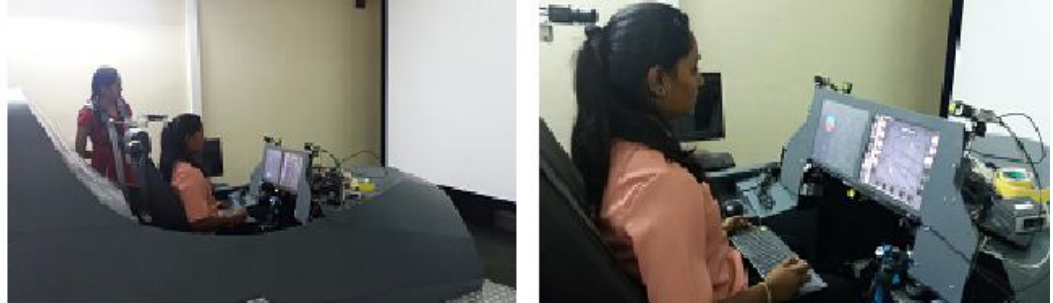
Figure 40. Testing with a high end simulator.